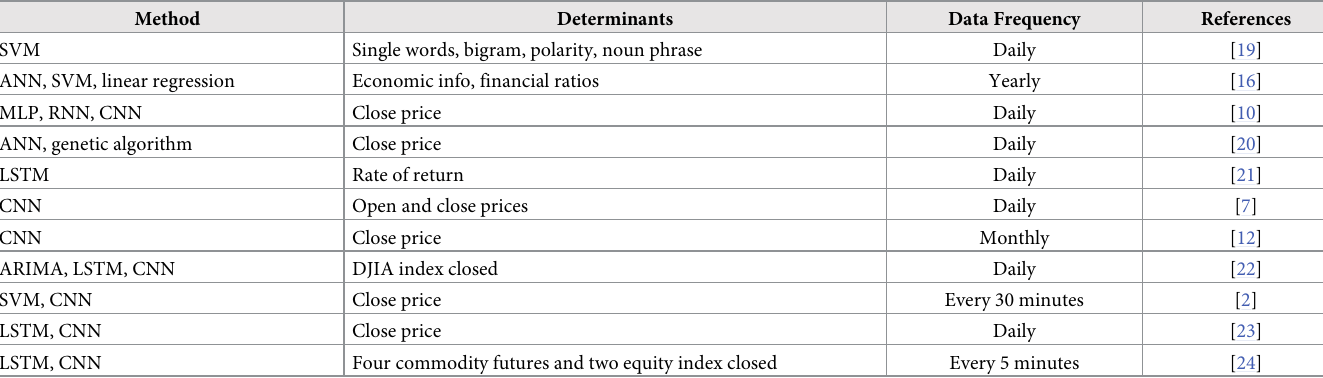
Table 1. Literature on stock price